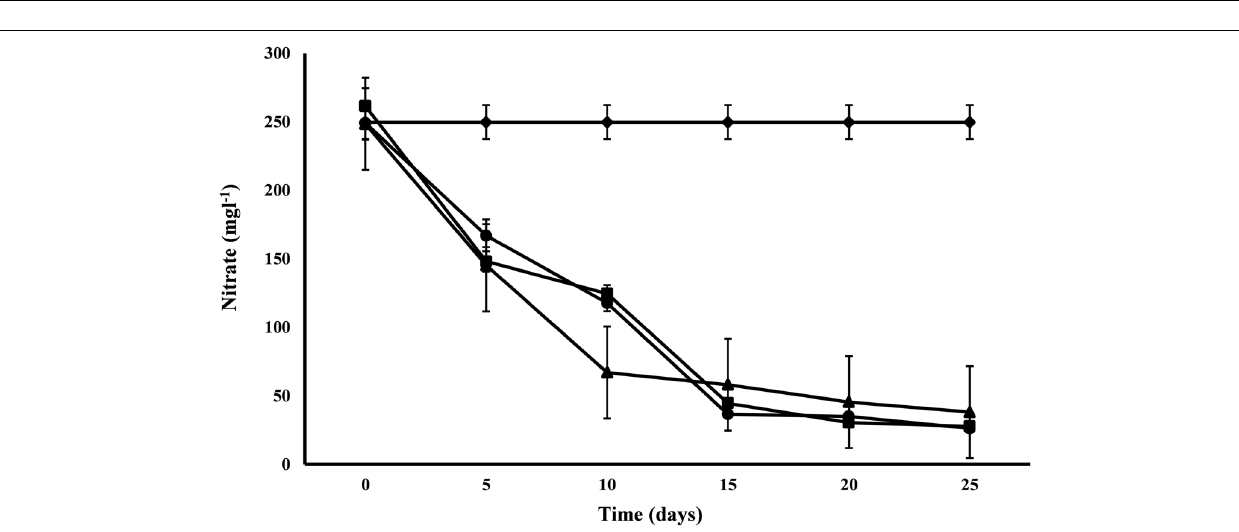
FIGURE 3 | COD reduction at alternate of 5 days in 3:1 ratio of DWW treated with A. ambigua, C. pyrenoidosa and S. abundans ( (cid:7) -control; (cid:4) - C. pyrenoidosa ; (cid:78) - S. abundans ; - A. ambigua ) (Values represent the mean ± SD of three replicates).